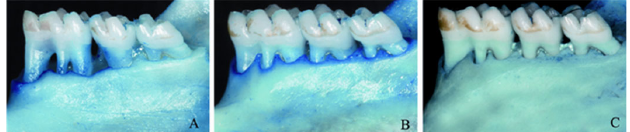
Fig. 2 - Representative photographs illustrating the morphologic findings of non- treatment [A] , C.V. extract [B] , and C.V. essential oil [C]